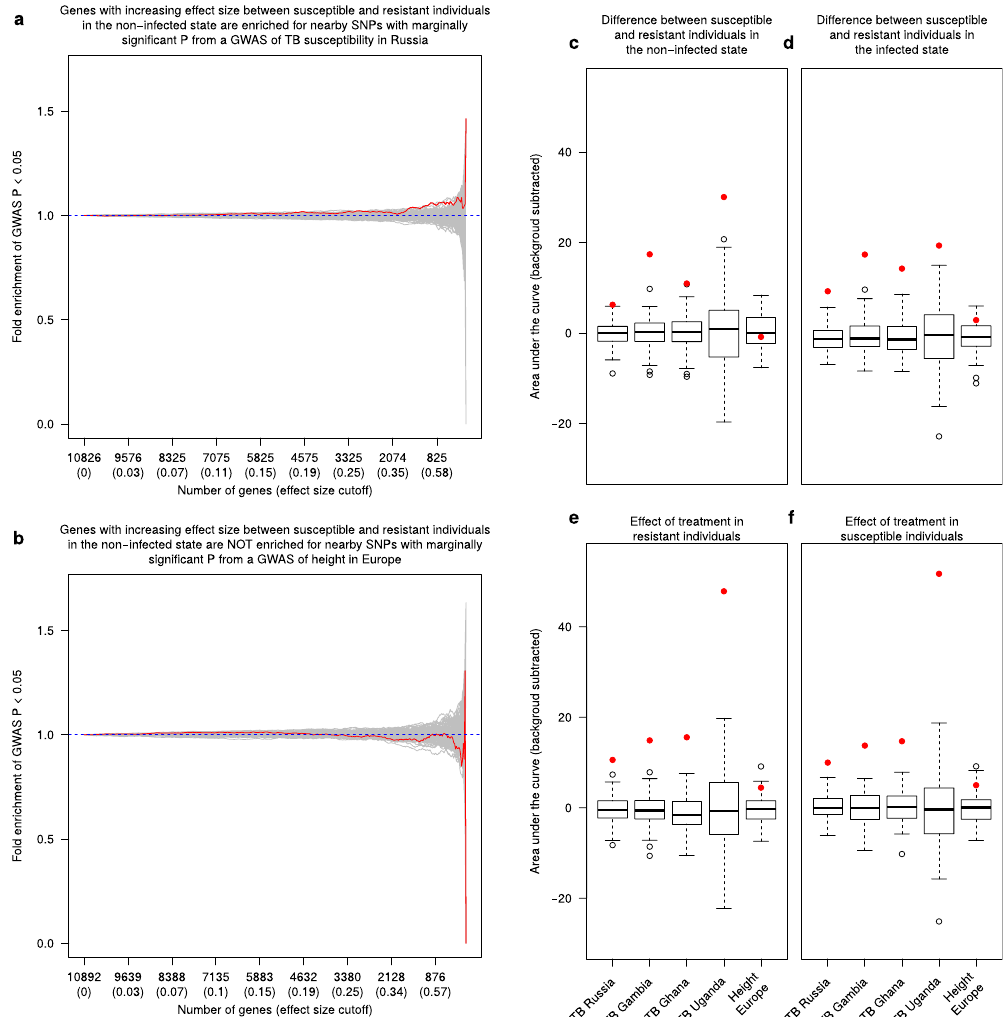
Figure 2. Comparison of differential expression and TB susceptibility GWAS results. ( a , b ) The y-axis is the fold enrichment of SNPs with p-value less than 0.05 from the ( a ) GWAS of TB susceptibility in Russia 18 or ( b ) height in individuals of European descent 25 . The x-axis is bins of genes with increasingly stringent effect size cutoffs of the absolute expression log fold change between putatively susceptible and resistant individuals in the non-infected state. The effect size cutoffs were chosen such that each bin from left to right contained approximately 25 fewer genes. The red line shows the results from the actual data. The grey lines are the results from 100 permutations. The dashed blue line at y = 1 represents the null expectation. ( c – f ) Boxplots of the area under the curve of the fold enrichment (red line in ( a , b )) minus the background level (blue y = 1 line in ( a , b )) for each of the 5 GWAS 13, 18, 19 considered for the 4 differential expression contrasts: ( c ) resistant vs. susceptible individuals in the non-infected state, ( d ) resistant vs. susceptible individuals in the infected state, ( e ) effect of treatment in resistant individuals, ( f ) effect of treatment in susceptible individuals. The boxplot is the result of the 100 permutations, and the red point is the result from the actual data. As a reference, the leftmost boxplot in ( c ) corresponds to the enrichment plot in ( a ), and the rightmost boxplot in ( c ) corresponds to the enrichment plot in ( b